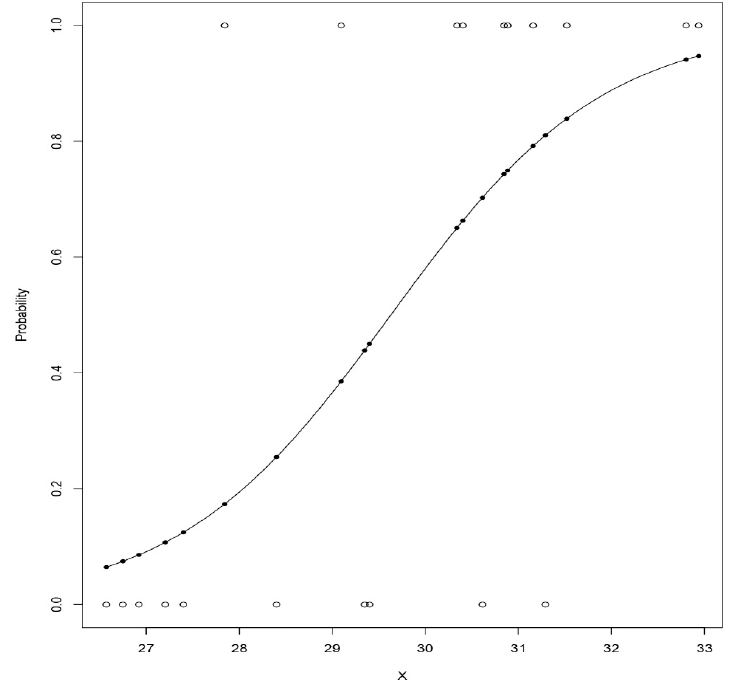
Figure 2. Sigmoidal Curve. Description: Here, ‘x’ can be any dependent attribute.